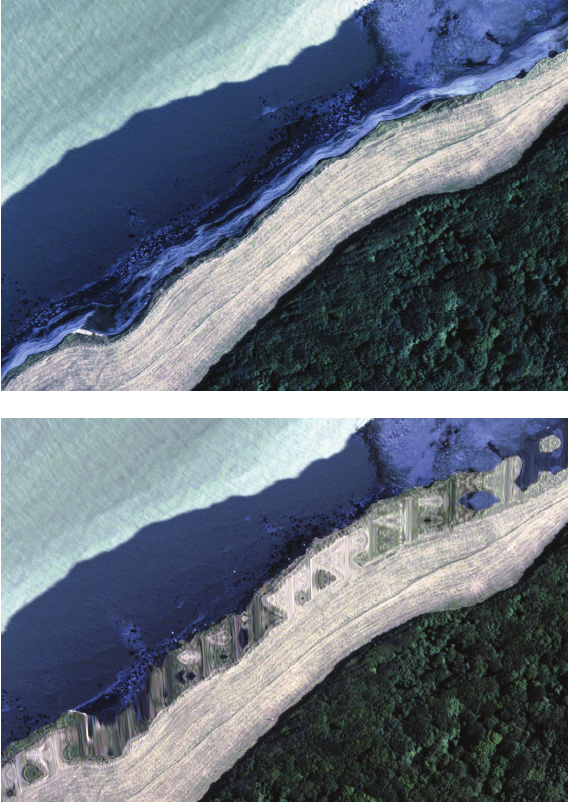
Figure 7. Precipitous chalk cliff on the French coast: shore platform (sea, foam and rocks) and land on bedrock (harvested field and wood) as showing on two orthorectified images, one with a strictly vertical viewpoint (above) and the other with a southern viewpoint